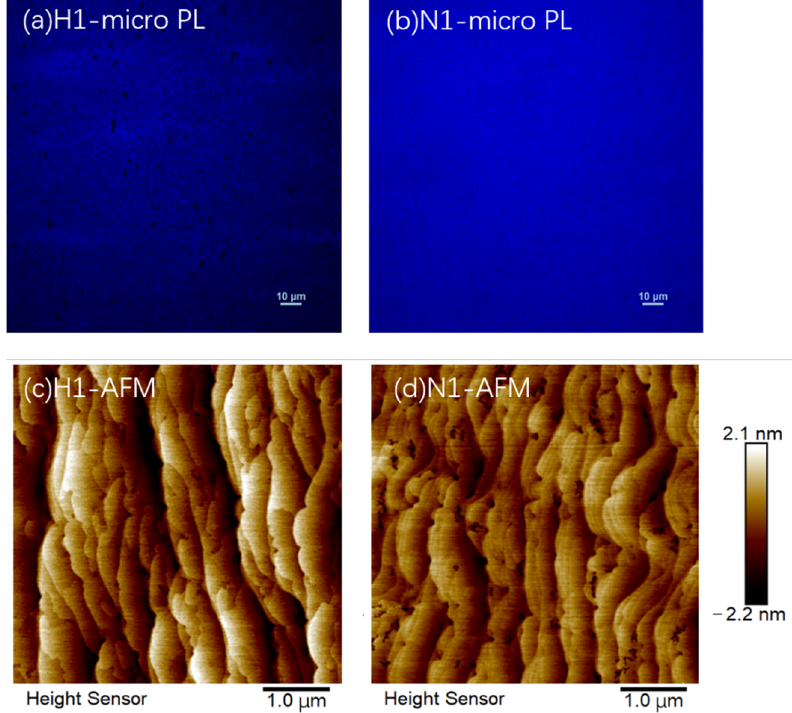
Figure 4. The micro-PL images of ( a ) sample H1 and ( b ) sample N1, where the brightness of dots is proportional to the PL luminescence intensity at each spot; the surface morphology measured by atomic force microscope in tapping mode for sample H1 ( c ), sample N1 ( d ).